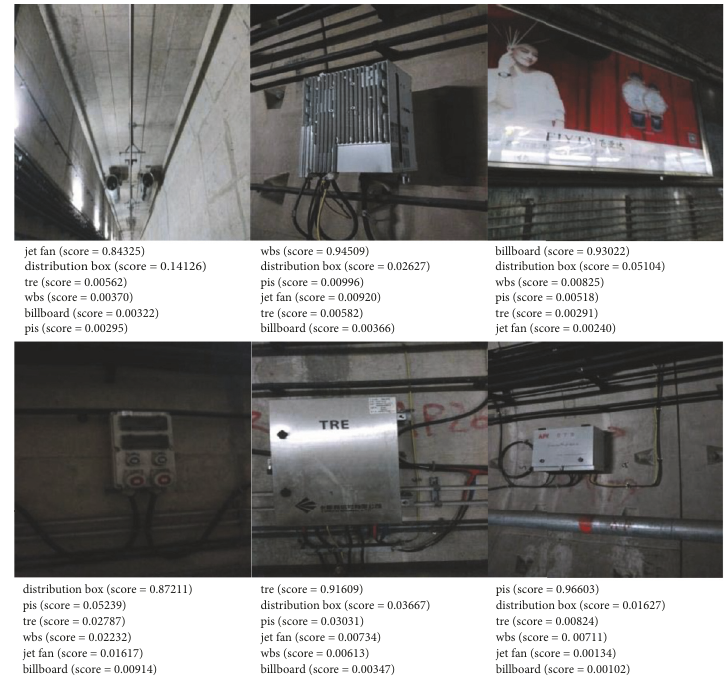
Figure 8: A few results.